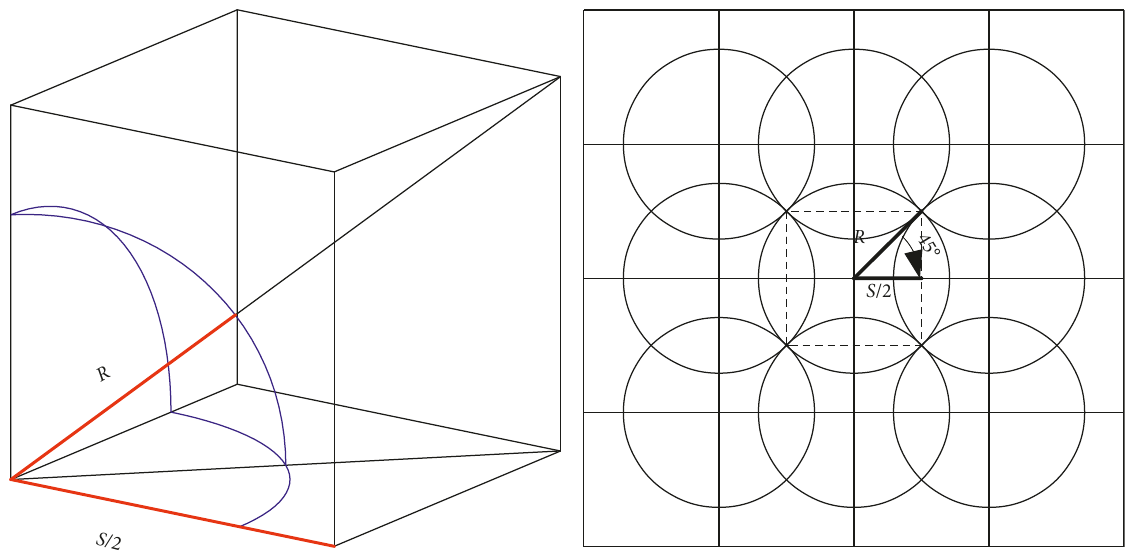
Figure 10: Sketch map of the spatial model: S is the grid spacing and R is the statistical smoothed